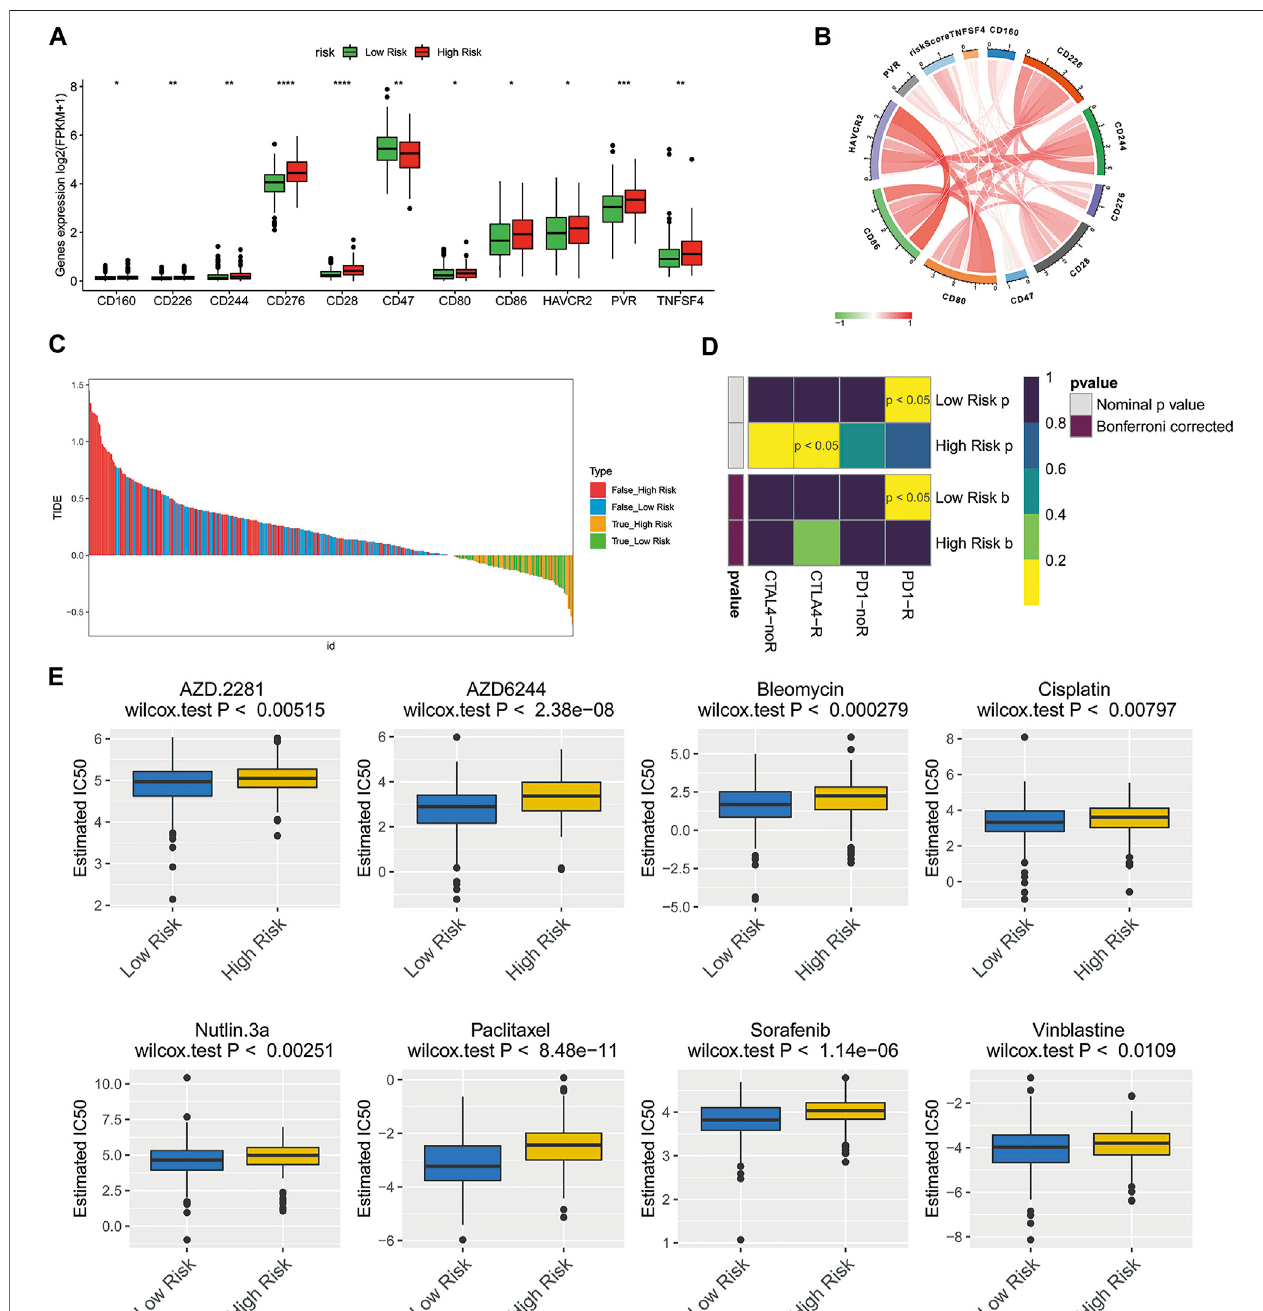
FIGURE 6 | Treatment response prediction of chemotherapy and immunotherapy in the high-risk and low-risk ovarian cancer patients. (A) Comparison of the expressionsoftheimmunecheckpointmoleculesbetweenthelow-andhigh-riskgroups.* p < 0.05;** p < 0.01;*** p < 0.001;**** p < 0.0001. (B) Circleplotillustratingthe association between risk score and main immune checkpoint molecules. (C) Immunotherapy response prediction of ovarian cancer patients in the low- and high-risk groups based on TIDE analysis. (D) Immunotherapeutic responses to anti-CTLA-4 and anti-PD-1 treatments in high- and low-risk patients. (E) IC50 values of 8 typical or potential therapeutic agents for ovarian cancer in the Genomics of Drug Sensitivity in Cancer database for low- and high-risk groups.